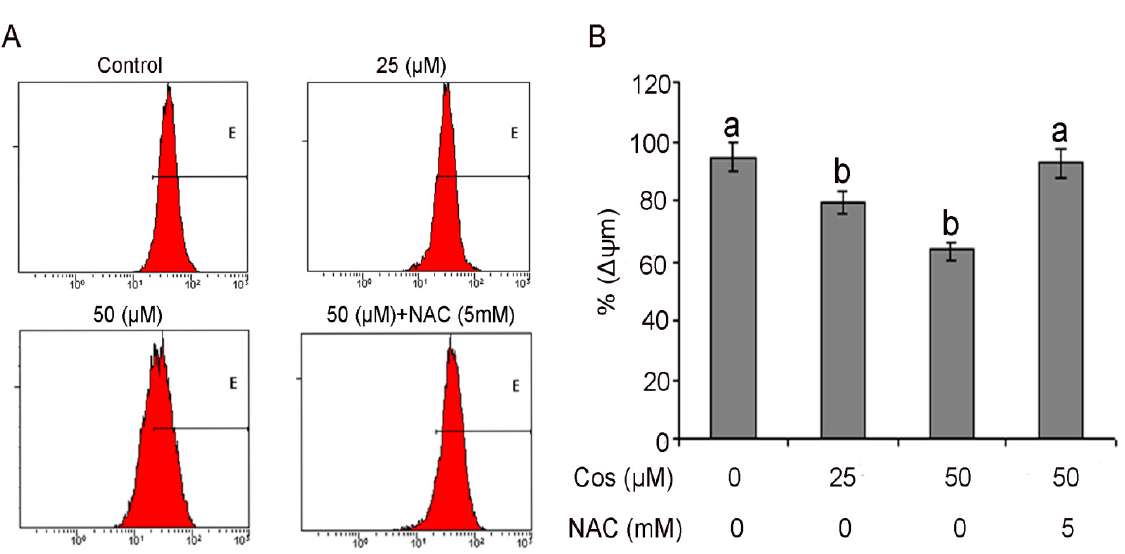
Figure 8. The effects of costunolide on mitochondrial transmembrane potential of T24 cells were determined by flow cytometry. ( A ) The values indicate the percentages of rhodamine 123 fluorescence in the T24 cells treated without and with 25 and 50 µM of costunolide for 24 h in the presence or absence of NAC. ( B ) Data are expressed as Mean ± SD (n = 3). Columns not sharing the same superscript letter differ significantly ( p <